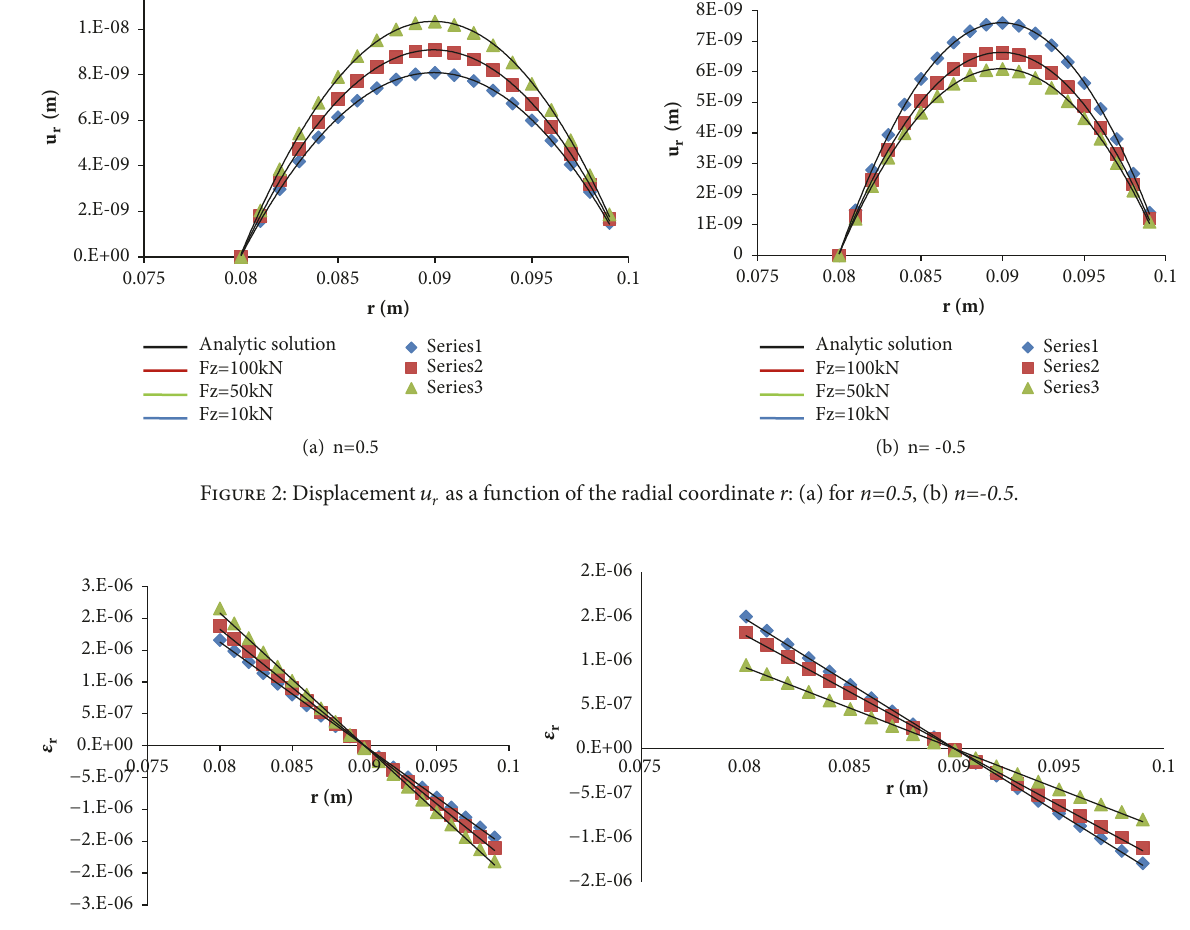
Fz=10kNFz=50kN Fz=100kNAnalytic solution